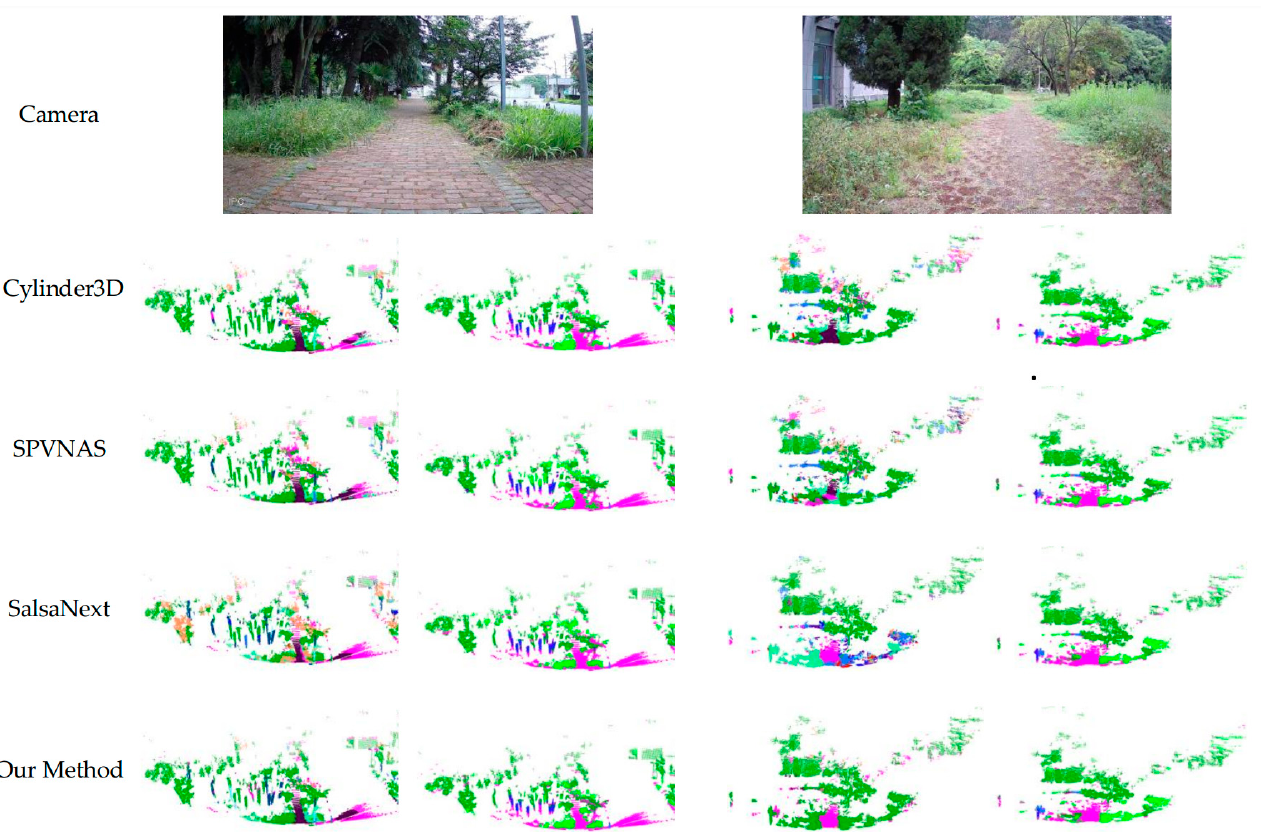
Figure 8. Visual comparison with different state-of-the-art methods on our unstructured test da- taset.